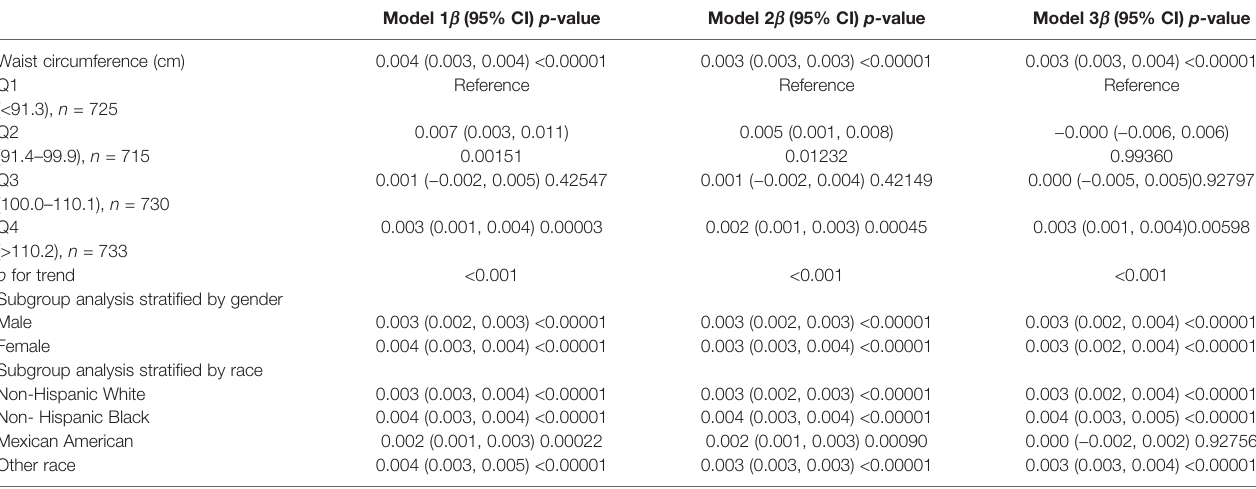
Model 1: No covariates were adjusted. Model 2: Age, gender, and race were adjusted. Model 3: Age, gender, race, education level, activities status, diabetes status, NAFLD status, smoking status, ALT, ALP, AST, total calcium, total cholesterol, direct HDL cholesterol, LDL cholesterol, triglyceride, and serum phosphorus were